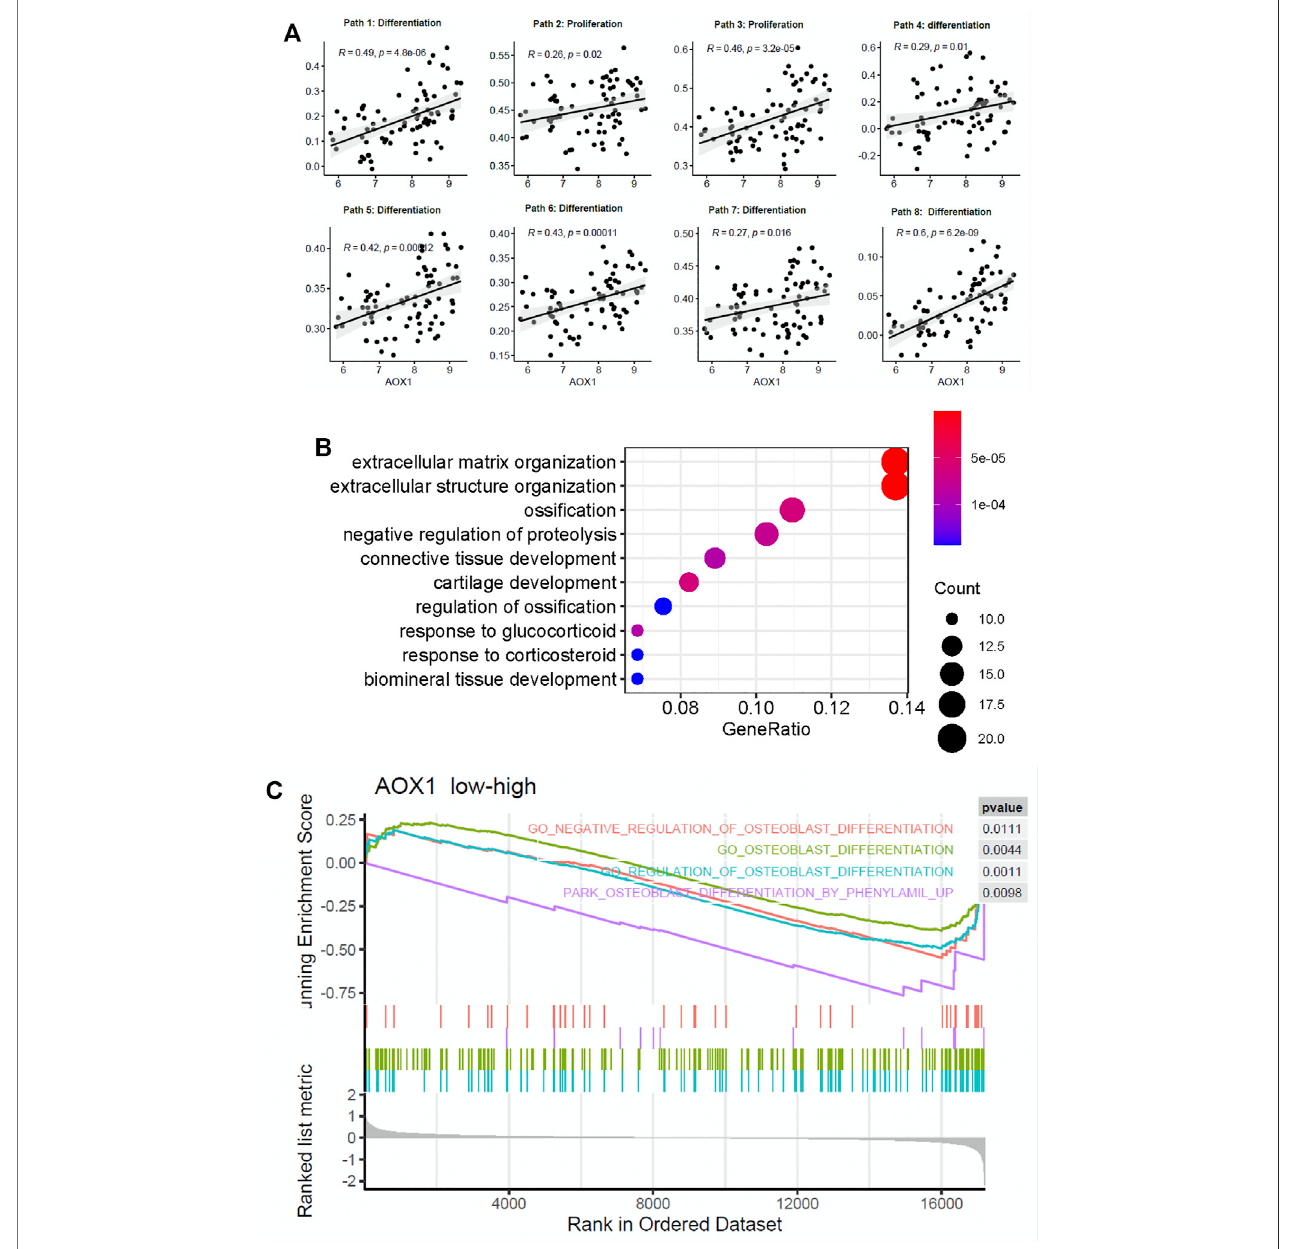
FIGURE5| AOX1isapotentialgenepositivelyregulatingtheosteogenicprocess. (A) Pointdiagram showsthepositivecorrelationbetweenAOX1expression and the enrichment score of osteogenic pathways (the detailed information of osteogenic pathways are presented in Supplementary Table). (B) Gene ontology enrichment analysis of these differentially expressed genes between the high AOX1 expression group and the low expression group. (C) Gene set enrichment analysis between the high AOX1 expression group and the low expression group.